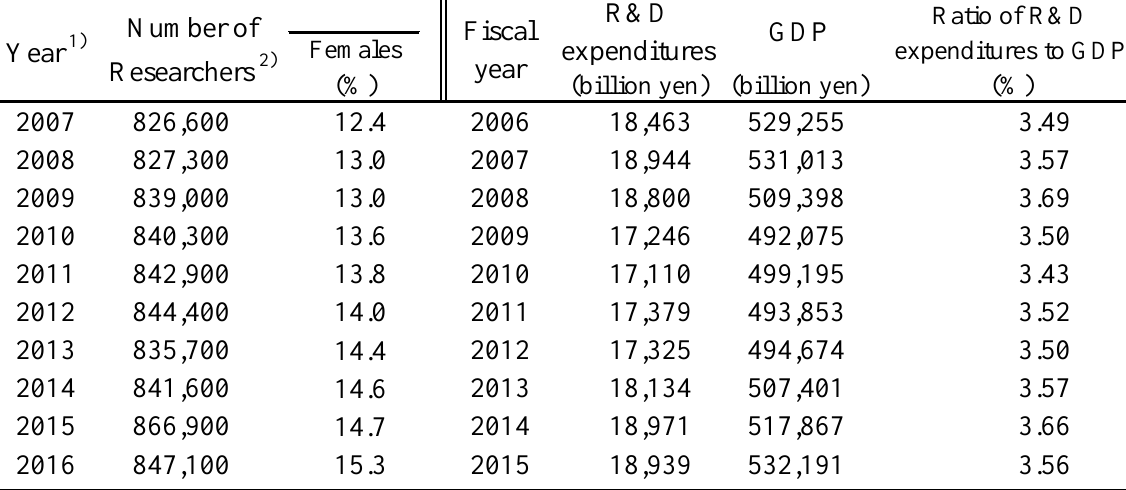
Trends in Research and